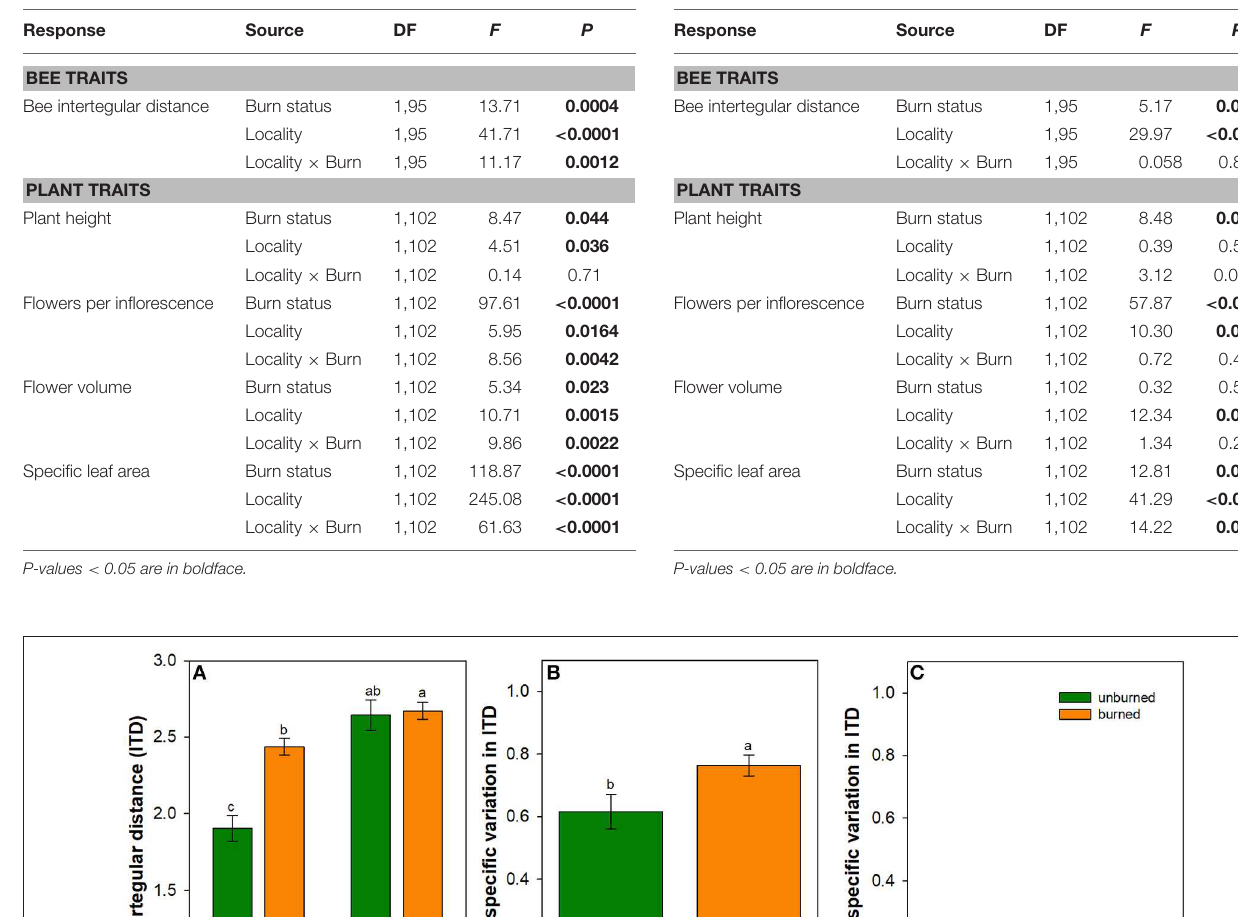
TABLE 3 | Results of two-way ANOVAs testing the effects of wildfire (i.e., burn status as burned or unburned), locality (i.e., Helena or Paradise) and their interaction on the mean interspecific variation in bee and plant traits of all individuals and species measured across plots.